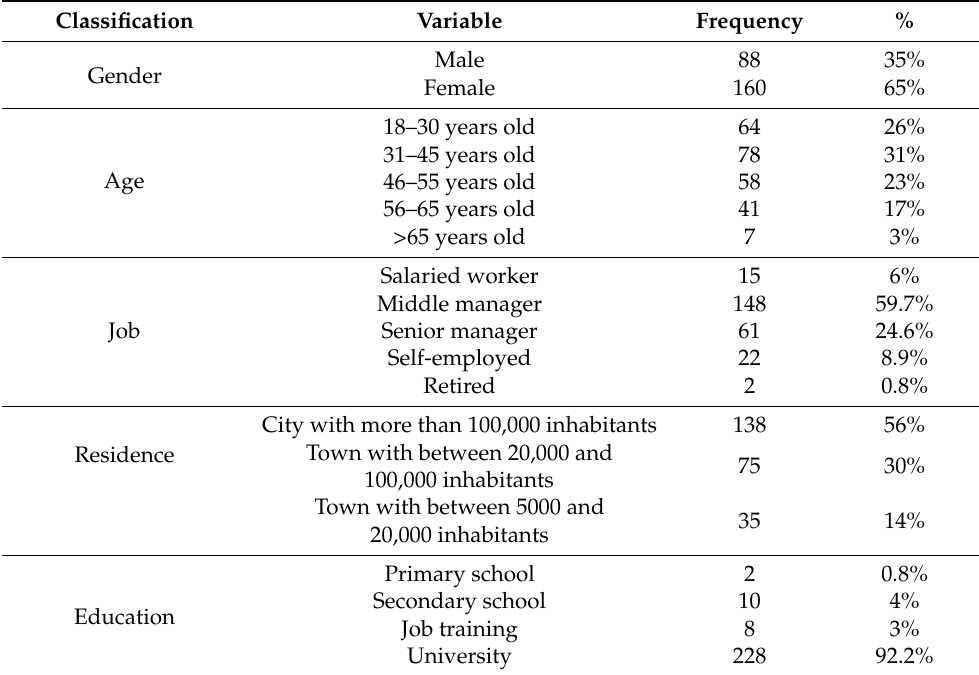
Table 2. Demographic Information ( n =